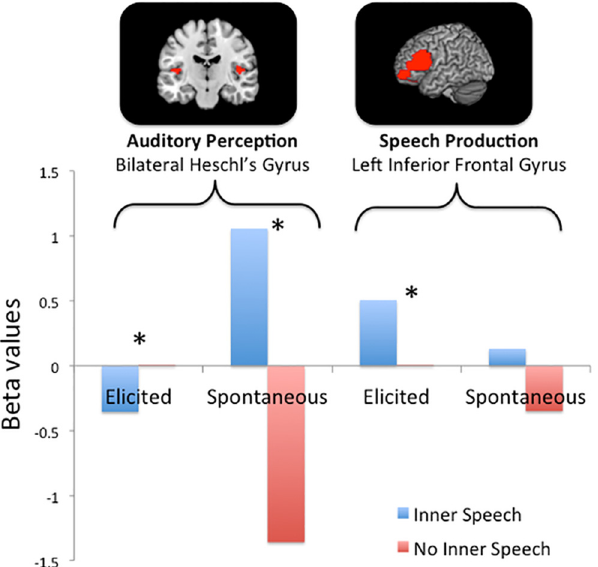
Fig 2. Beta-values extracted from brain regions associated with auditory perception (Heschl ’ s gyrus) and speech production (left inferior frontal gyrus). In the elicited condition, speech was prompted by means of visual cues. In the spontaneous condition, Descriptive Experience Sampling was used to capture naturally occurring moments of inner speech.